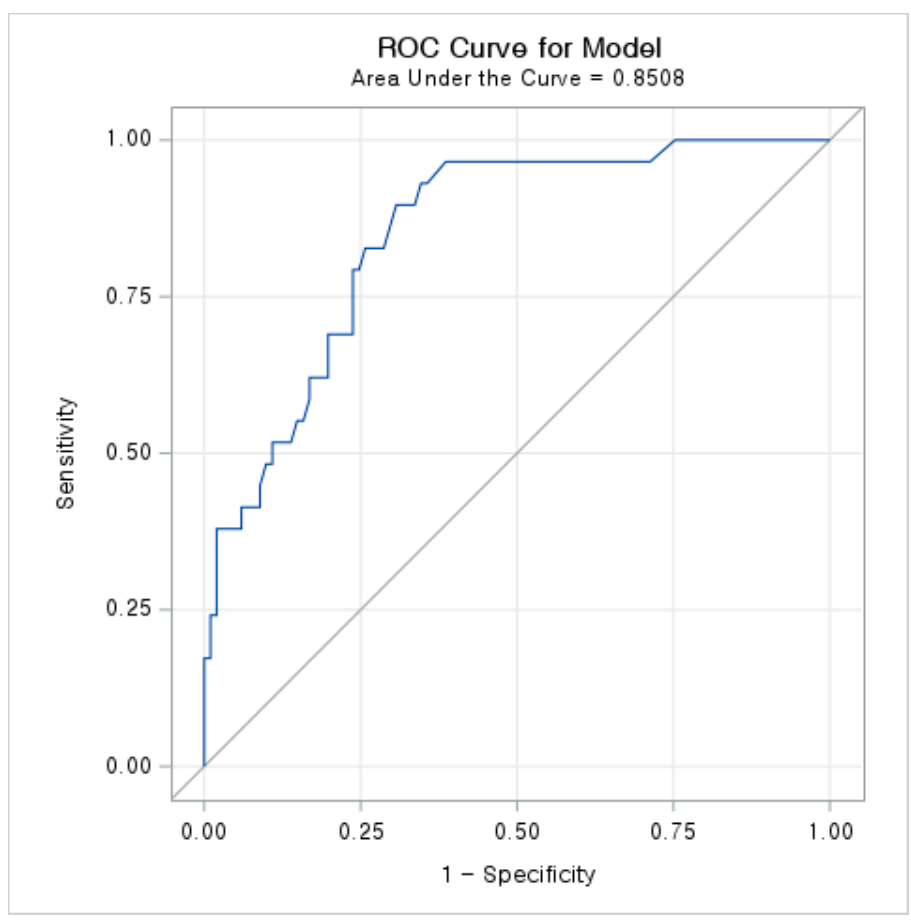
Figure 2. ROC curve and AUC assessing the predictive accuracy of multivariate model for new-onset mental disorder during hospitalization. ROC = receiver operating characteristic; AUC = area under curve.